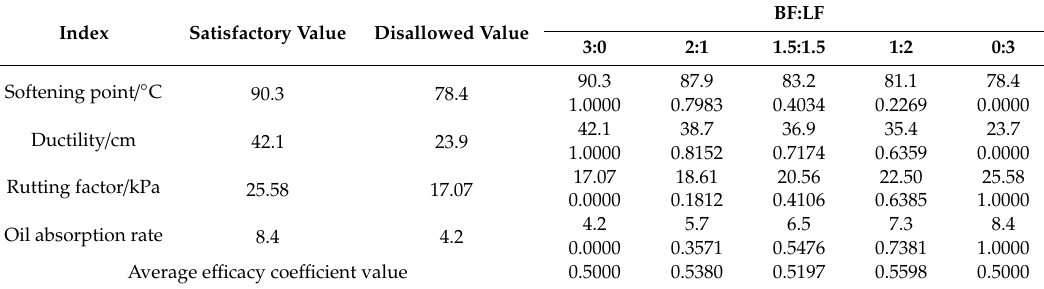
Table 5. Calculation of the e ffi cacy coe ffi